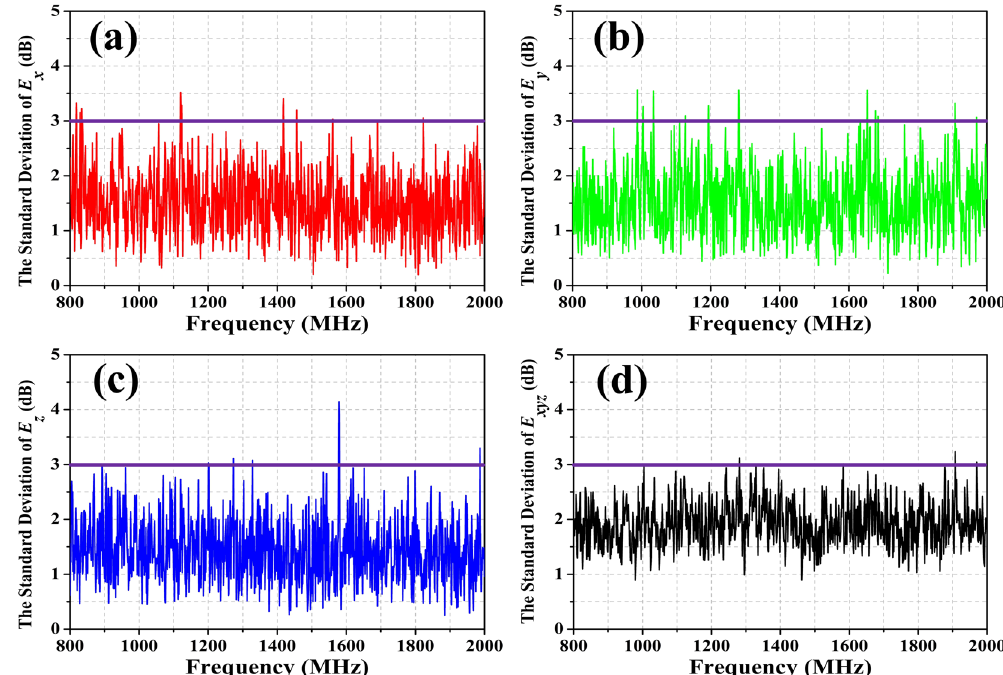
Figure 6. The standard deviations of the field strengths in the mechanical stirrer RC. The purple lines are the tolerance requirements for the standard deviation of; 13 ( a ) the x-component, ( b ) the y-component, ( c ) the z-component, ( d ) the combination of xyz